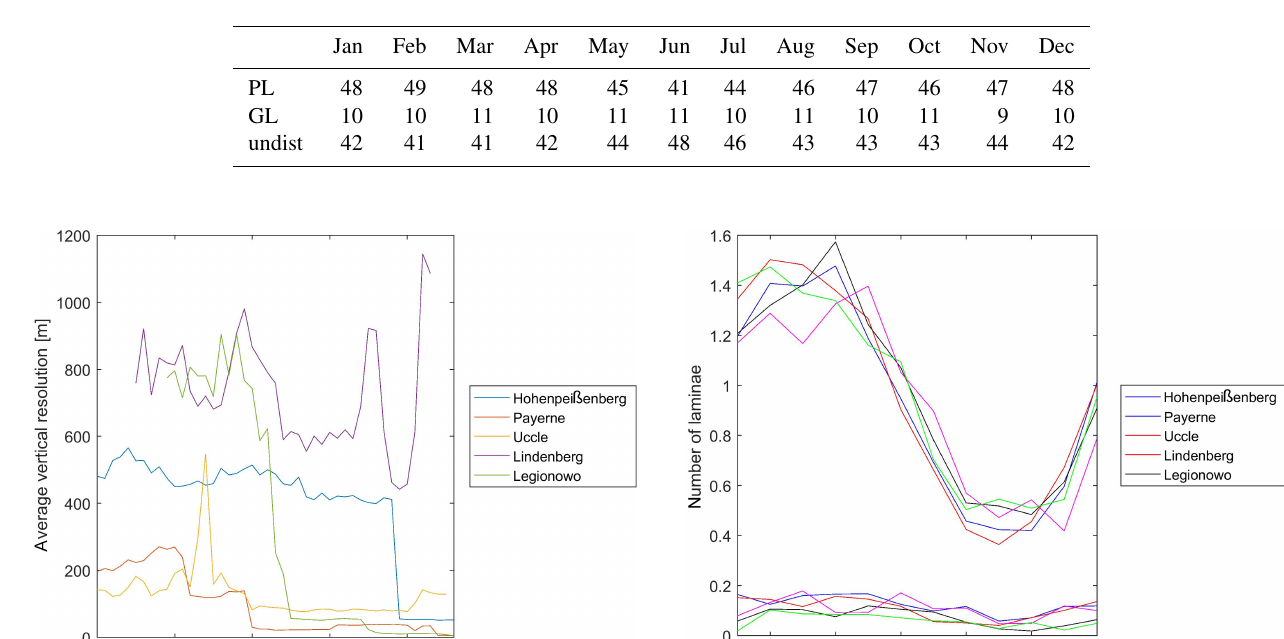
Table 1. Monthly composition of laminae (%) at Hohenpeissenberg in the period 1970–2016 (undistinguishable laminae).